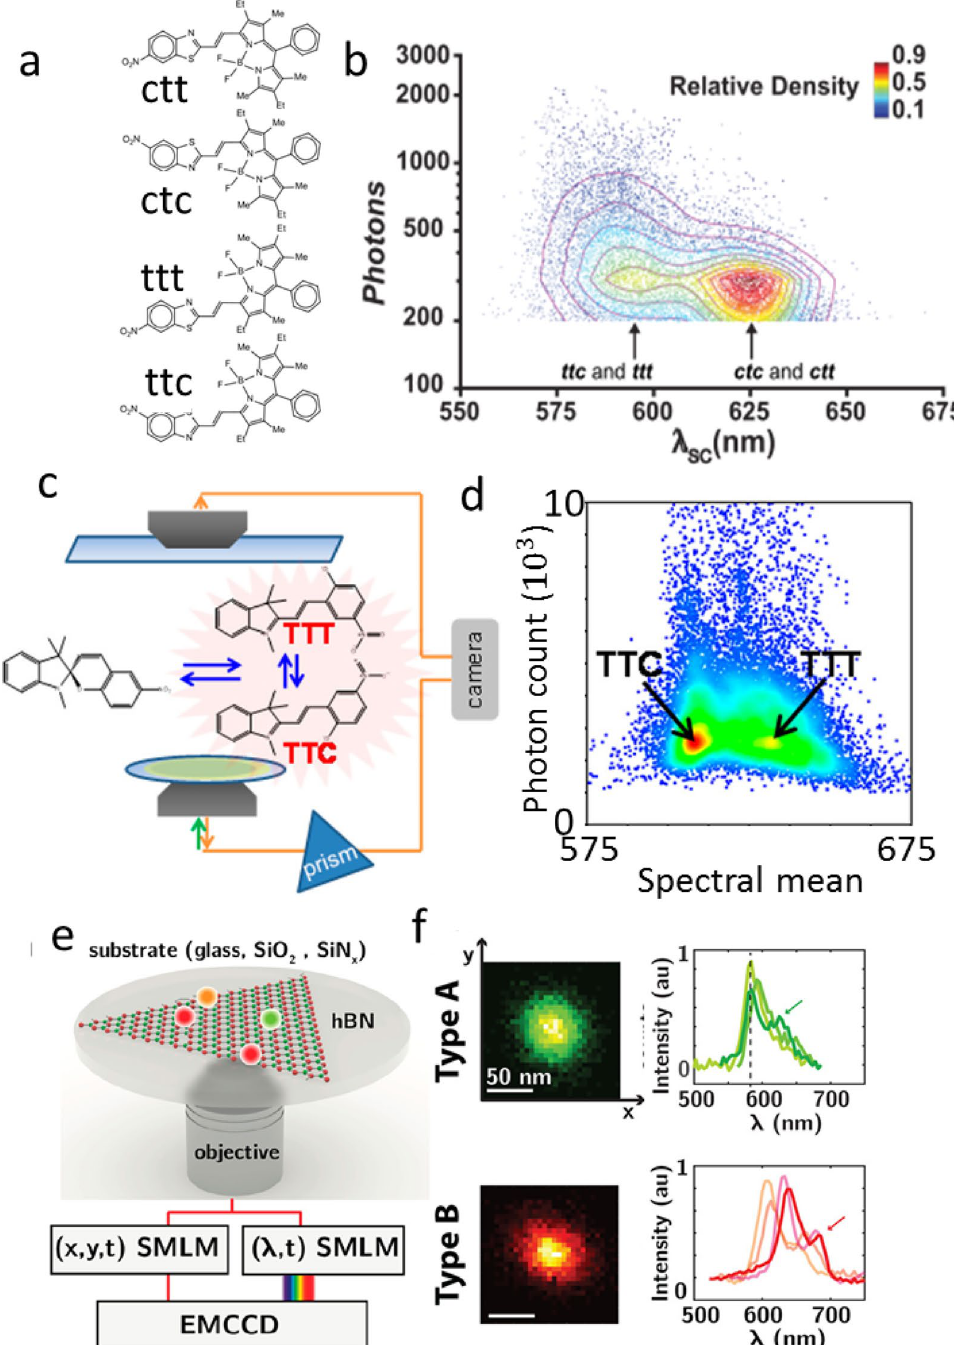
Fig. 5 a Structures of the four conformational isomers of a BODIPY derivative; b Scatterplot of the corresponding single-molecule emission intensity against the spectral centroid with the relative density of distribution; c Schematic of the optical configuration to detect the two isomers of merocyanine; d Spectral histogram showing the detection of two distinct populations of merocyanine. Reprinted with permission from [47]; e Illustration of the sSMLM imaging of emitters on hexagonal boron nitride; f Spatial image and spectrum of the two defects on hexagonal boron nitride (Reprinted with permission from